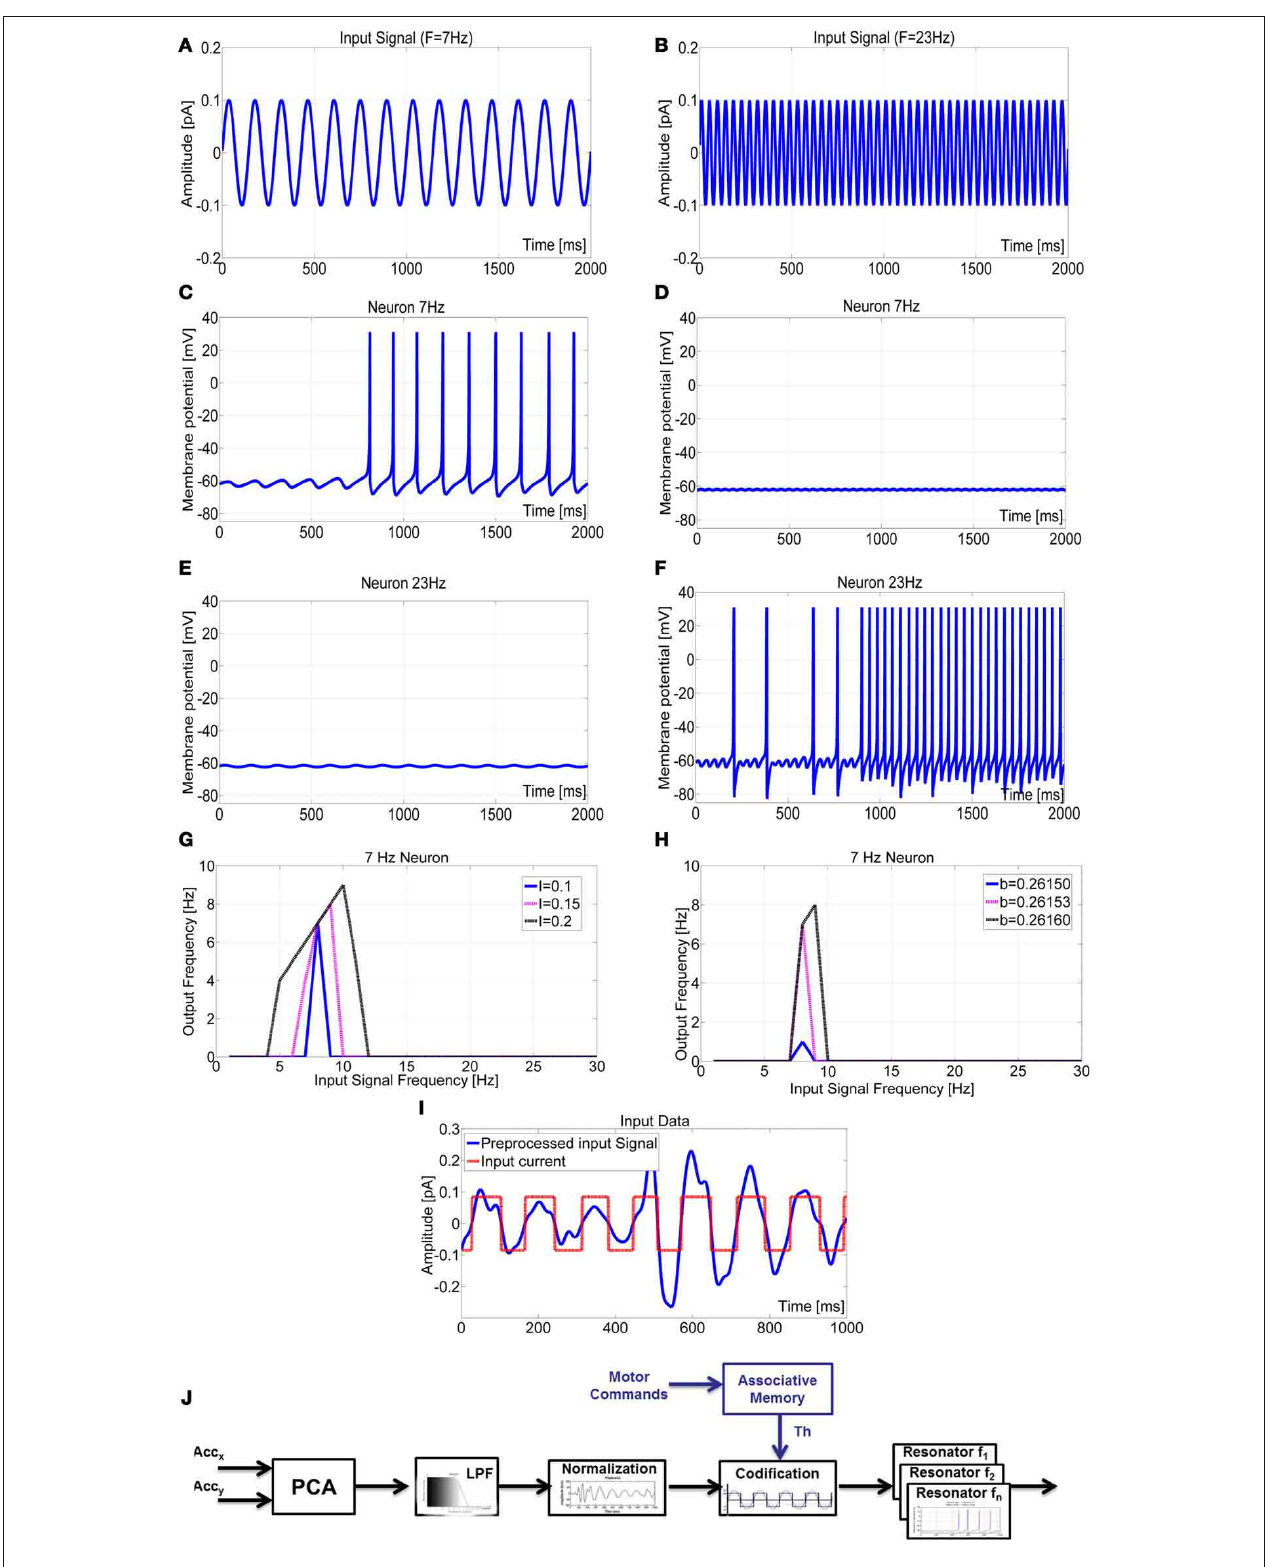
FIGURE 8 | Behavior of two neurons tuned to stimulus frequencies of 7Hz (A) and 23Hz (B). Membrane potential of the 7Hz neuron showed